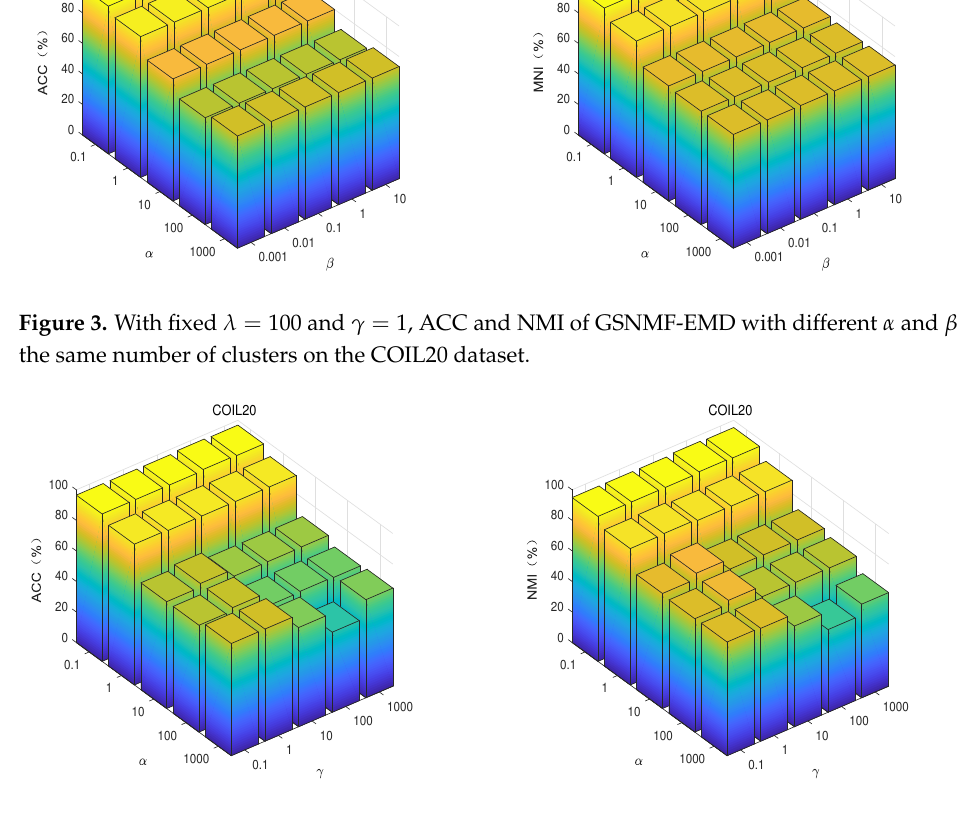
Figure 4. With fixed λ = 100 and β = 2, ACC and NMI of GSNMF-EMD with different α and γ and the same number of clusters on the COIL20 dataset.